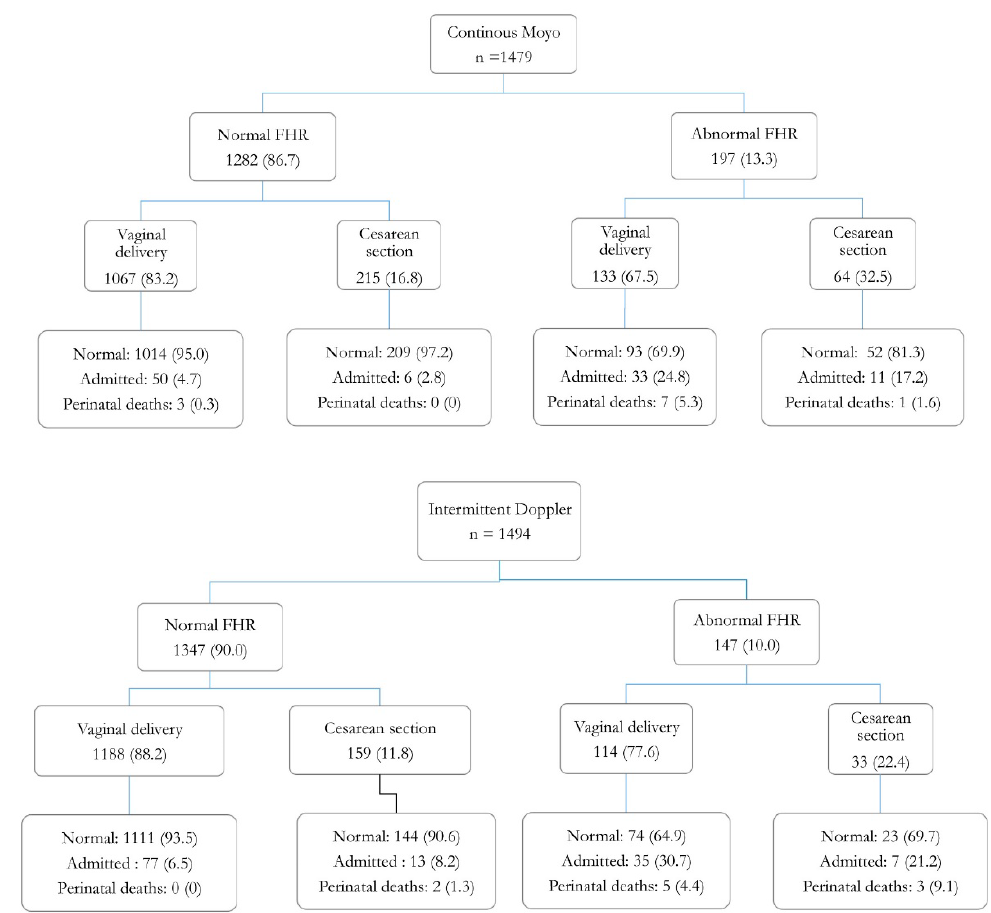
Figure 4. Flow diagrams of foetal heart rate (FHR) detections, mode of delivery, and perinatal outcomes in continuous Moyo and intermittent Doppler.